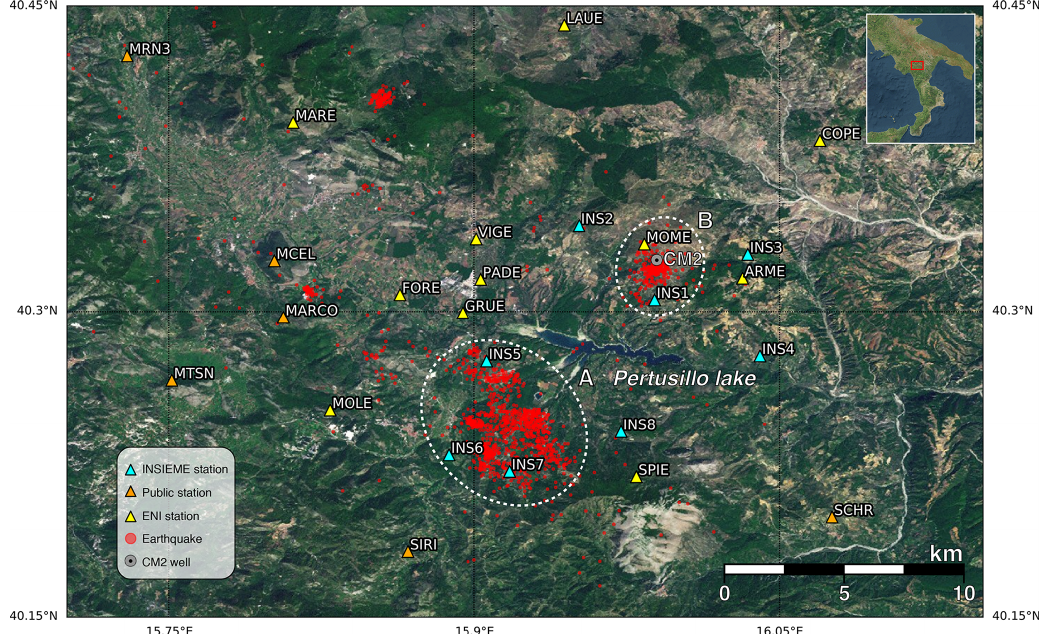
Figure 1. Layout of the INSIEME seismic network in the High Agri Valley. Cyan triangles represent the eight broadband seismic stations of the network. Yellow and orange triangles represent stations belonging to private (i.e. the Eni Company) and public seismic monitoring networks, respectively. The CM2 injection well is depicted with a black dot inside a grey circle. Natural and anthropogenic earthquakes are represented with red circles (2002–2012 seismicity from Serlenga and Stabile, 2019). Anthropogenic seismicity is classified as seismicity induced by continued reservoir (clusters A) and fluid injection (cluster B). The map was drawn using Matplotlib Python library (Hunter, 2007), which incorporates the ArcGIS REST Services freely available at http://server.arcgisonline.com/arcgis/rest/services (last access: Jan- uary